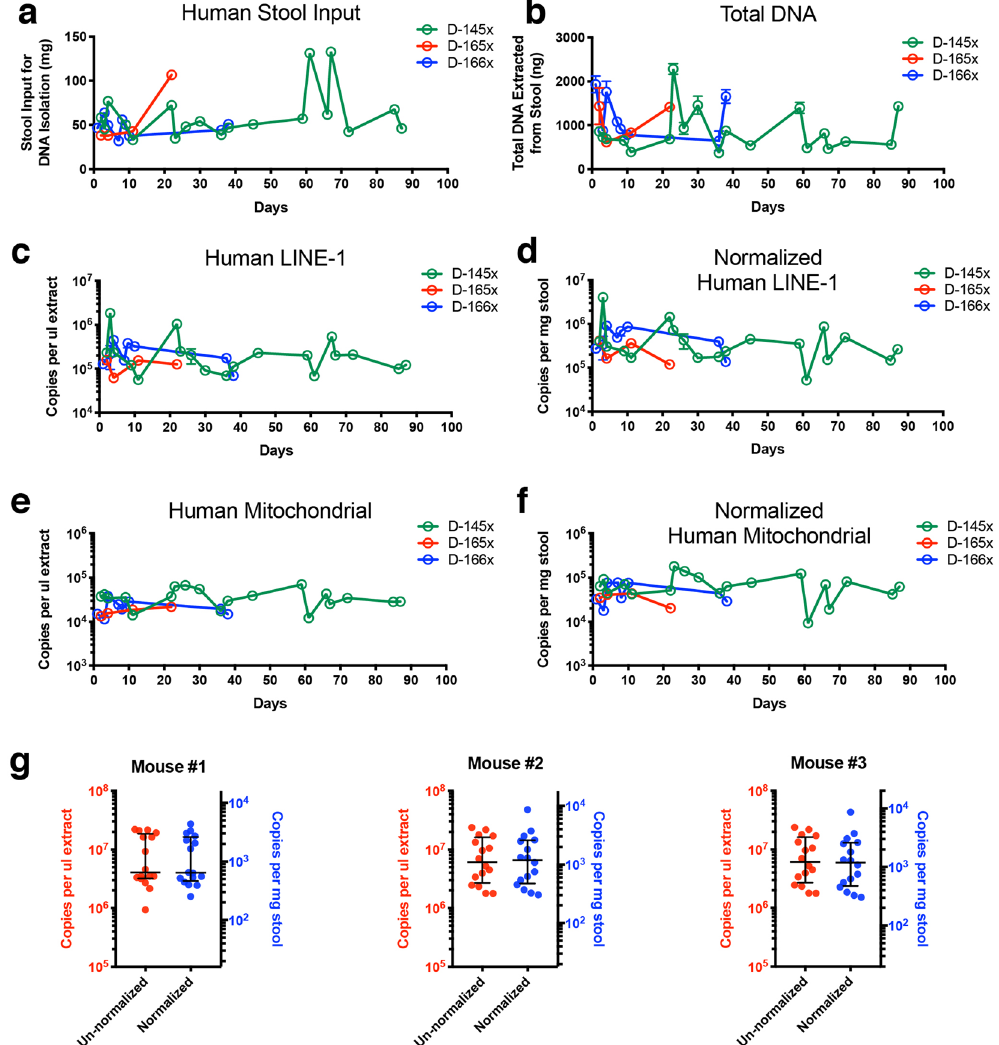
Figure 6. Quantification of host DNA from healthy human and murine stools using ddPCR. ( a ) Plot showing the variation in amount of stool input used for DNA purification for each of the longitudinally collected stool specimens from three healthy humans (D-145x, D-165x, and D-166x). ( b ) total DNA isolated from the amounts of stool shown in ( a ). The error bars represent the range of total DNA isolated from two side-by-side purifications per specimen. ( c ) Human DNA quantified from total fecal DNA extracts using the human LINE-1 (60-bp amplicon) assay, expressed in copies per μ l DNA extract. ( d ) Human DNA quantified from total fecal DNA extracts using the human LINE-1 (60-bp amplicon) assay, normalized by expressing as copies per mg stool. ( e ) Human DNA quantified from total fecal DNA extracts using the human mt (83-bp amplicon in the ND5 gene) assay, expressed in copies per μ l DNA extract. ( f ) Human DNA quantified from total fecal DNA extracts using the human mt (83-bp amplicon in the ND5 gene) assay, normalized by expressing as copies per mg stool. Error bars in ( c–f ) represent range of copy numbers from single ddPCR reactions on the duplicate DNA extraction. ( g ) Quantification of mouse DNA in stools collected from three healthy mice using the mouse LINE-1 (58-bp amplicon) assay. LINE-1 levels are plotted as copies per μ l stool DNA extract and copies per mg stool for each mouse. The horizontal lines represent the median and interquartile